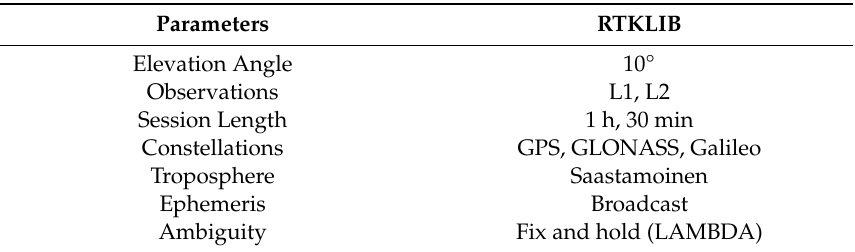
Table 1. Used RTKLIB parameters for data